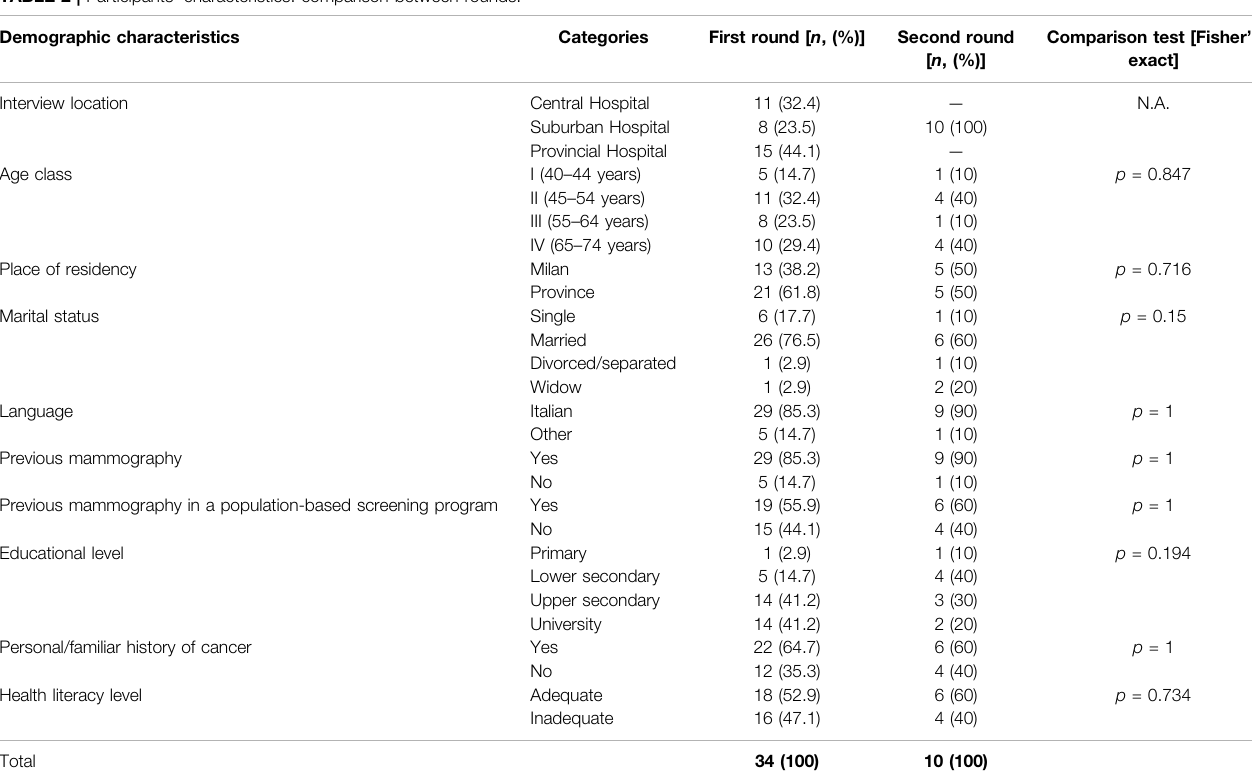
TABLE 2 | Participants ’ characteristics: comparison between